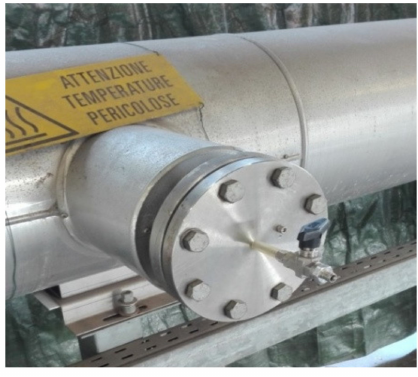
Figure 7. Sampling